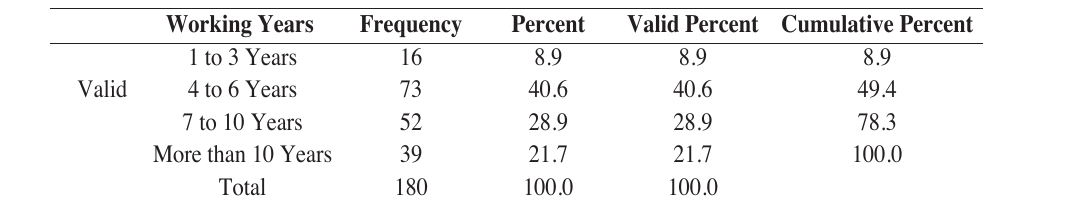
Table 4. Working Years of Respondents